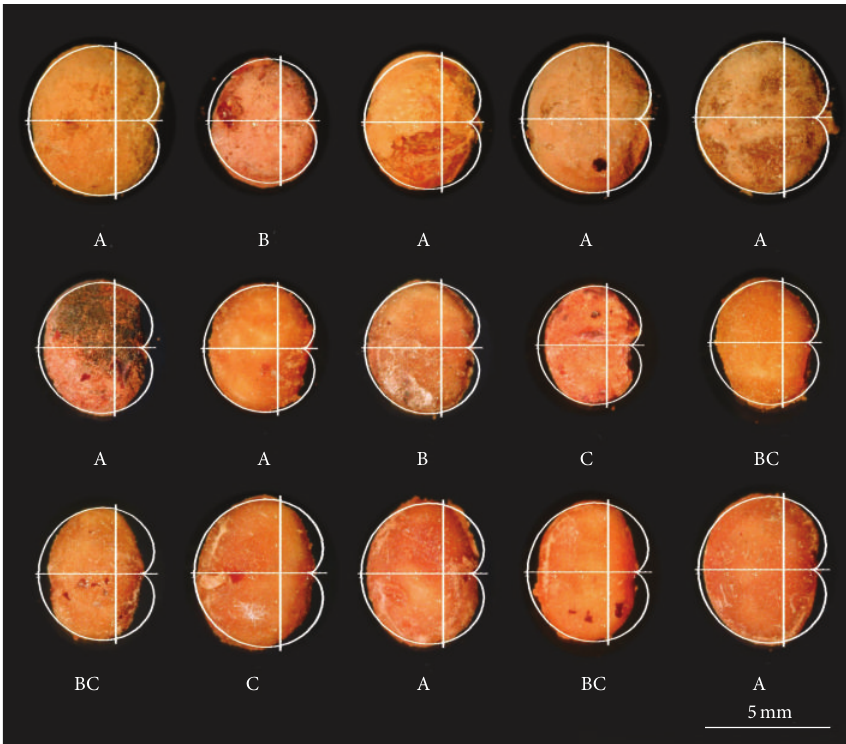
Figure 7: A model based on the cardioid was applied to seeds of Rhus tripartita (Ucria) Grande (Anacardiaceae; Saadaoui et al., submitted). Four morphological types were described in this work. Type A: seeds in which similarity with the cardioid is above 92 in the left region and above 80 in the right. Type B: seeds whose values of similarity with the cardioid curve are below 92 in the left region and above 80 in the right of the seed. Type C: seeds whose values of similarity with the cardioid curve are below 80 in the right part of the seed and above 92 in the left. Type BC: seeds in which similarity with the cardioid curve is below 92 per cent in the right and below 80 per cent in the right part of the seed. Plants grown in different climates had distinct proportions of seed